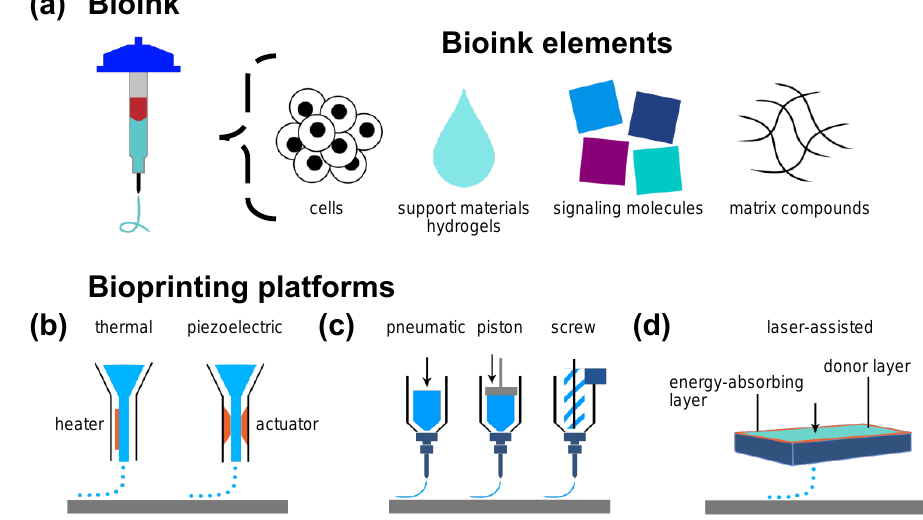
Figure 1. Overview of bioink elements and common bioprinting platforms. ( a ) Bioink composition. The main elements of bioinks are cells, support materials—mostly hydrogels—signaling molecules, and matrix compounds. ( b ) Jet-based drop-on-demand bioprinting enables droplet-based bioink deposition. Droplet formation and deposition can be induced, for example, thermally induced air pressure or piezoelectric pressure. ( c ) Microextrusion bioprinting is based on bioink filament extrusion to fabricate constructs in a layer-by-layer fashion. Bioink extrusion is facilitated by pneumatic or mechanical forces (piston or screw system). ( d ) Laser-assisted bioprinting enables bioink deposition on a receiving substrate layer by pulsed-laser-induced forward transfer (arrow) via an energy- absorbing